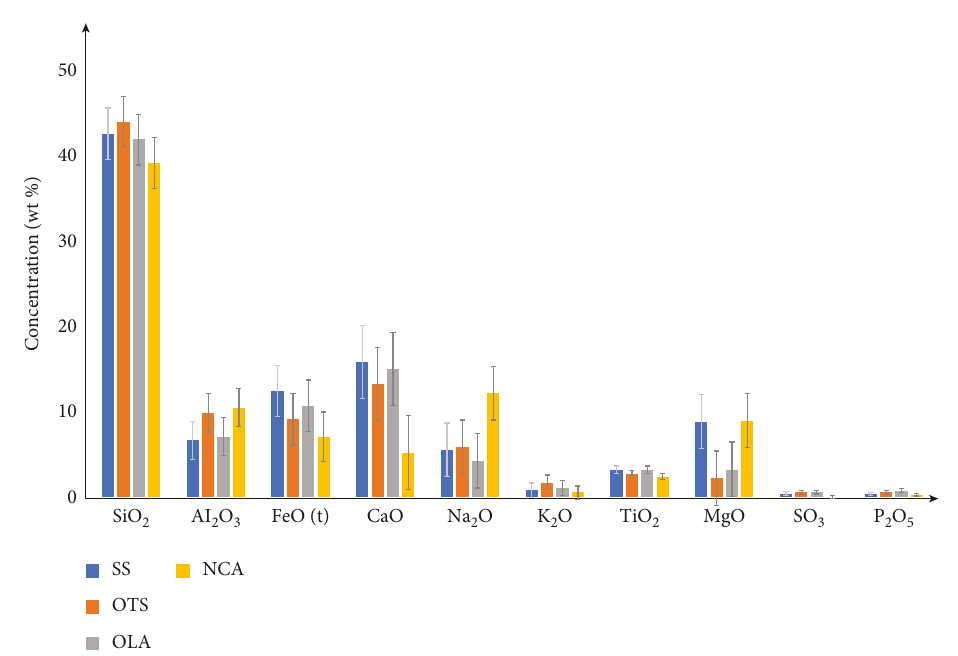
Figure 10: A graph of the average concentration of major oxides of SS, OTS, OLA, and NCA samples.